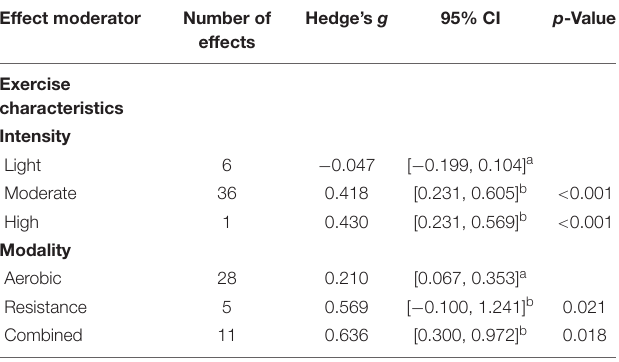
TABLE 4 | Univariate results for significant energy categorical moderator variables.